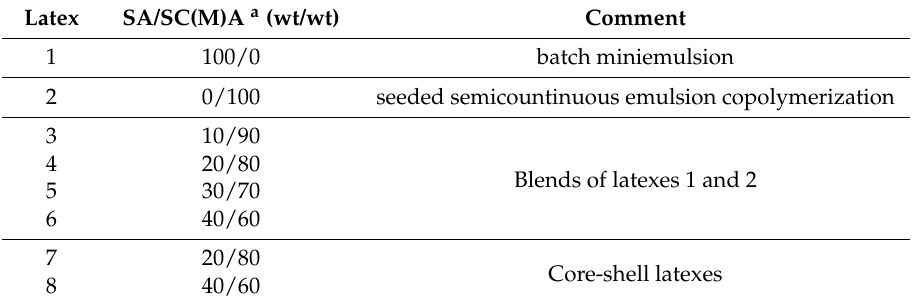
Table 1. Summary of latexes